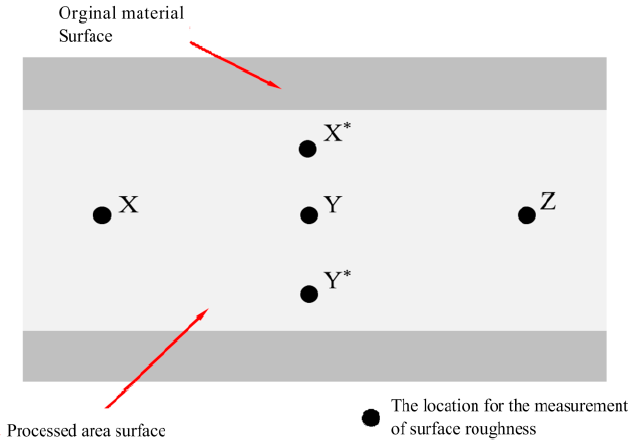
Figure 3. Five measurement points for the surface roughness of the specimen.